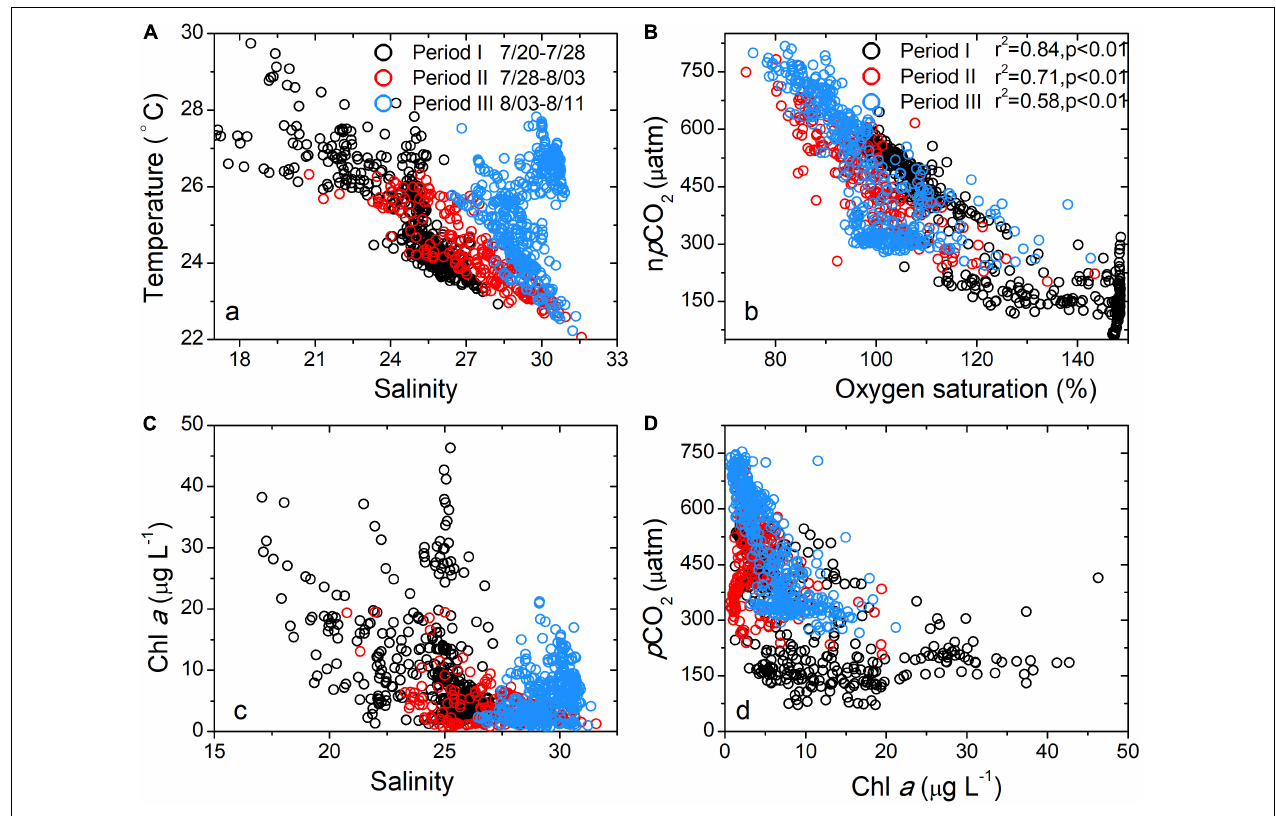
FIGURE 4 | Relationships among buoy-measured salinity and temperature (A) , oxygen saturation and n p CO 2 (B) , Chl a and p CO 2 (C) , salinity and Chl a (D)